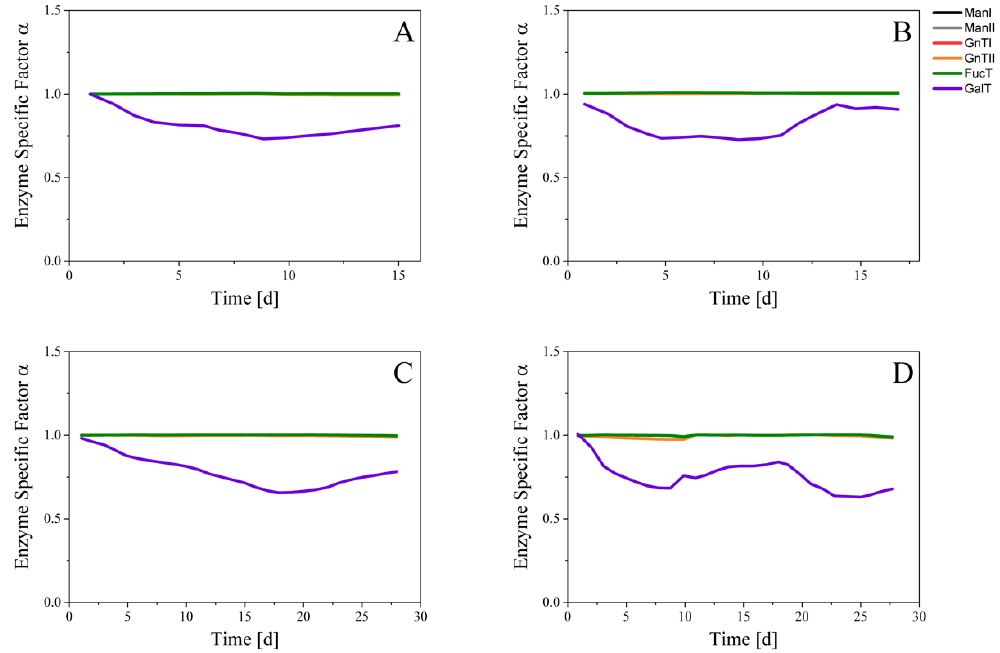
Figure 7. Predicted enzyme-specific factors. The activity of fluxes catalyzed by Man I (black), Man II (grey), GnT I (red), GnT II (orange) and FucT (green) remain relatively constant in all experiments. However, the fluxes catalyzed by GalT (purple) shows significant variation over the course of the four perfusion cell culture experiments ( A ), ( B ), ( C ) and ( D ).